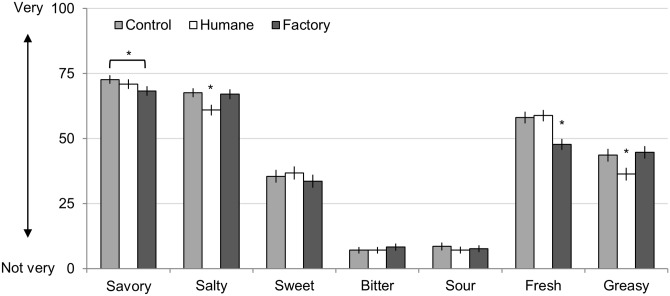
Study 3: Flavor Ratings of Ham Sample.Error bars represent standard errors, and asterisks represent significance (* p < 0.05). All ratings made on 100-point slider scales.